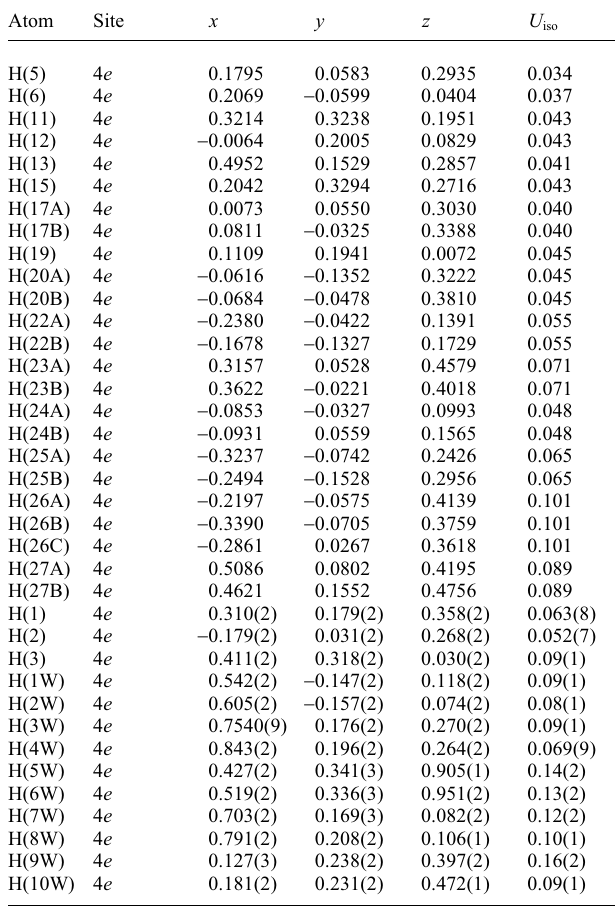
Table 2. Atomic coordinates and displacement parameters (in Å 2 )